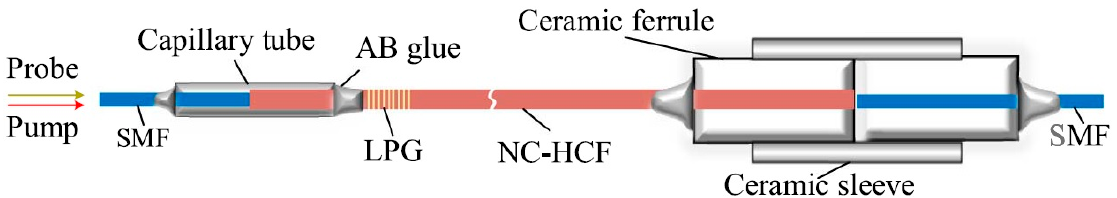
Figure 12. Schematic of the absorption cell formed by an NC-HCF with LPG inscribed in it. The absorption cell forms an in-line dual-mode interferometer. The probe and pump beams were delivered to and outcoupled from the NC-HCF using the butt-coupling approach with SMFs. Reprinted with permission from [22] © The Optical Society.